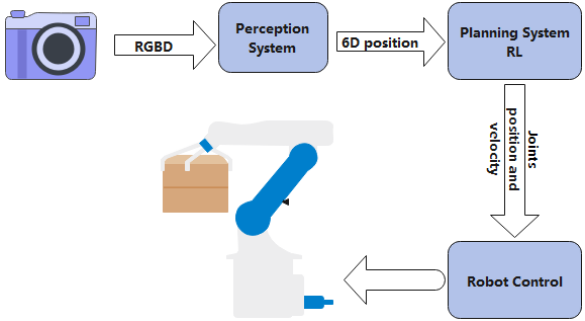
Figure 1. Classic robotic manipulation